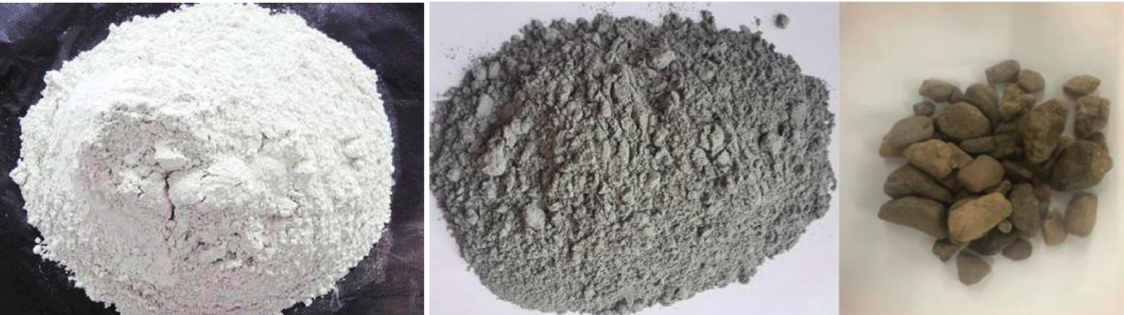
Figure 1: Slag powder, fly ash, and large size cobbles.